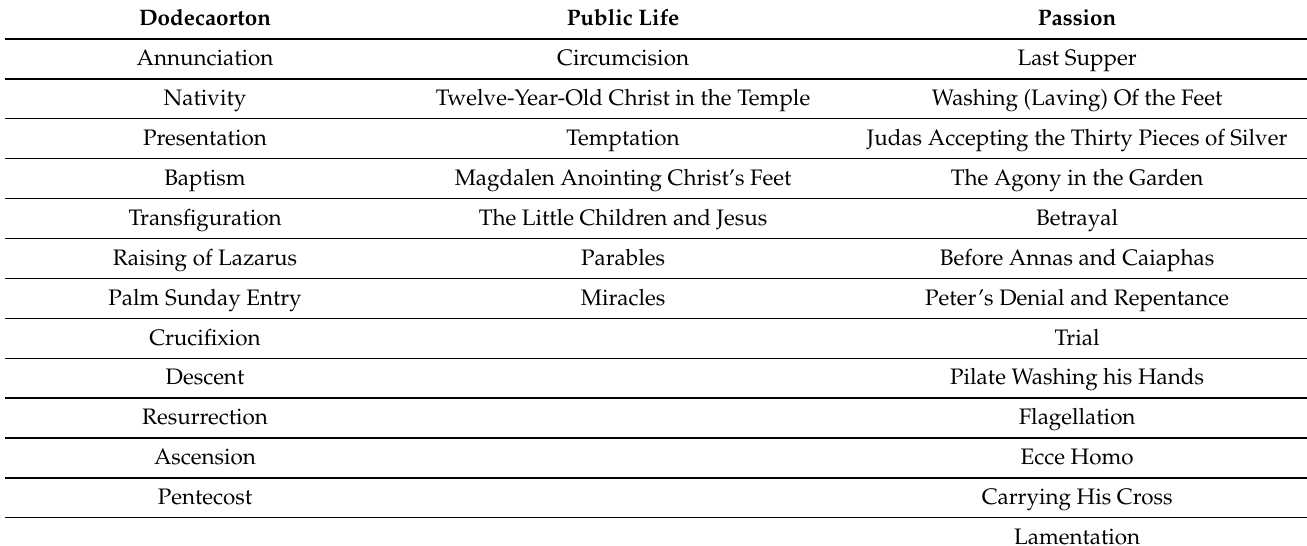
Table 1. The Christological Cycle.